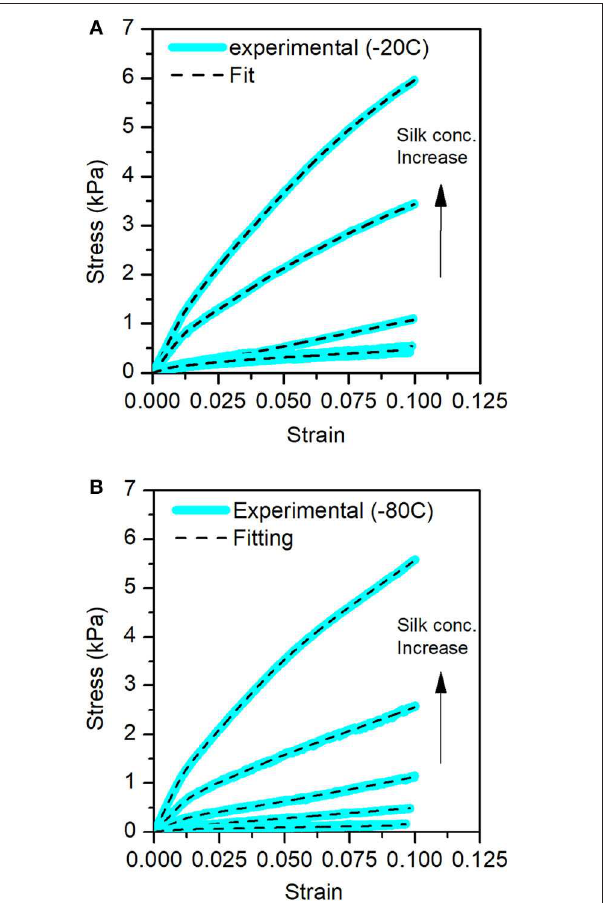
FIGURE 7 | Stress-Strain curves for the different sponge scaffolds obtained from the compression tests. In blue, the experimental data and the fits in the dashed lines. (A) At − 20 ◦ C and (B) at − 80 ◦